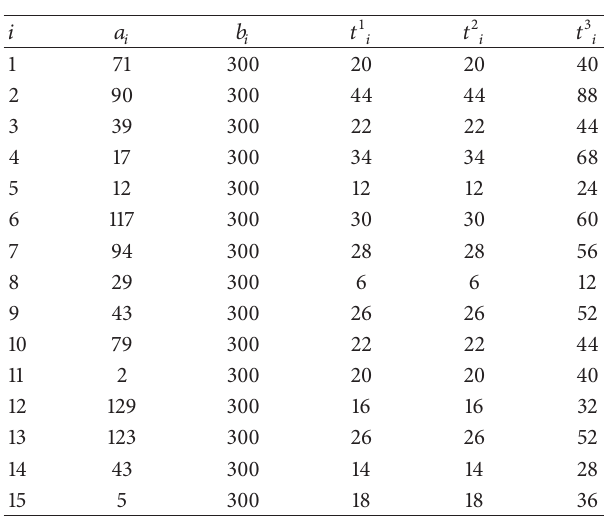
Table 2: Information of 15